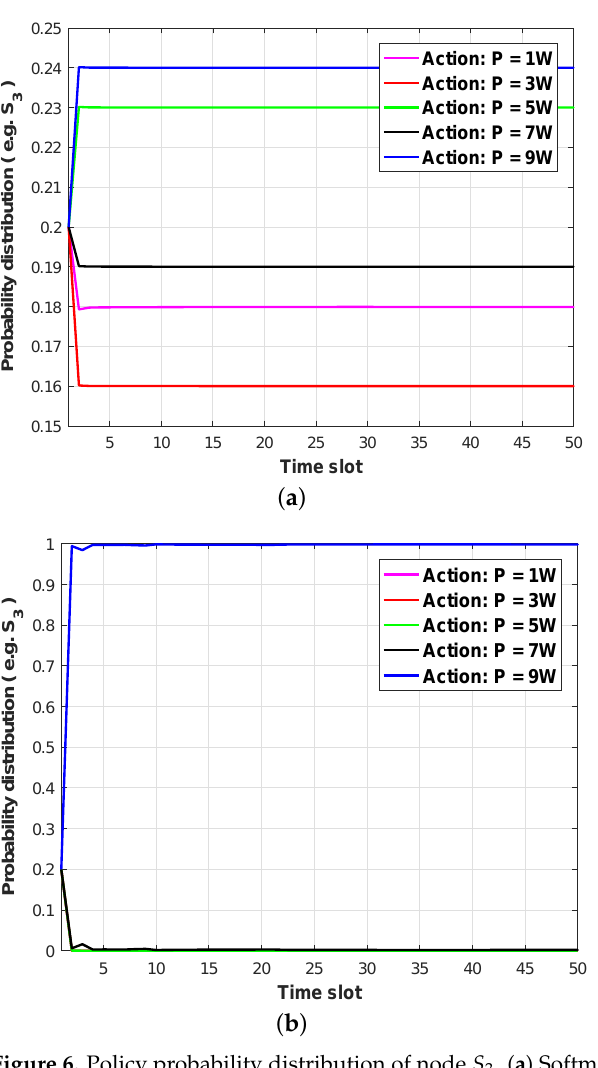
Figure 6. Policy probability distribution of node S 3 . ( a ) Softmax-greedy strategy. ( b ) HGL strategy.